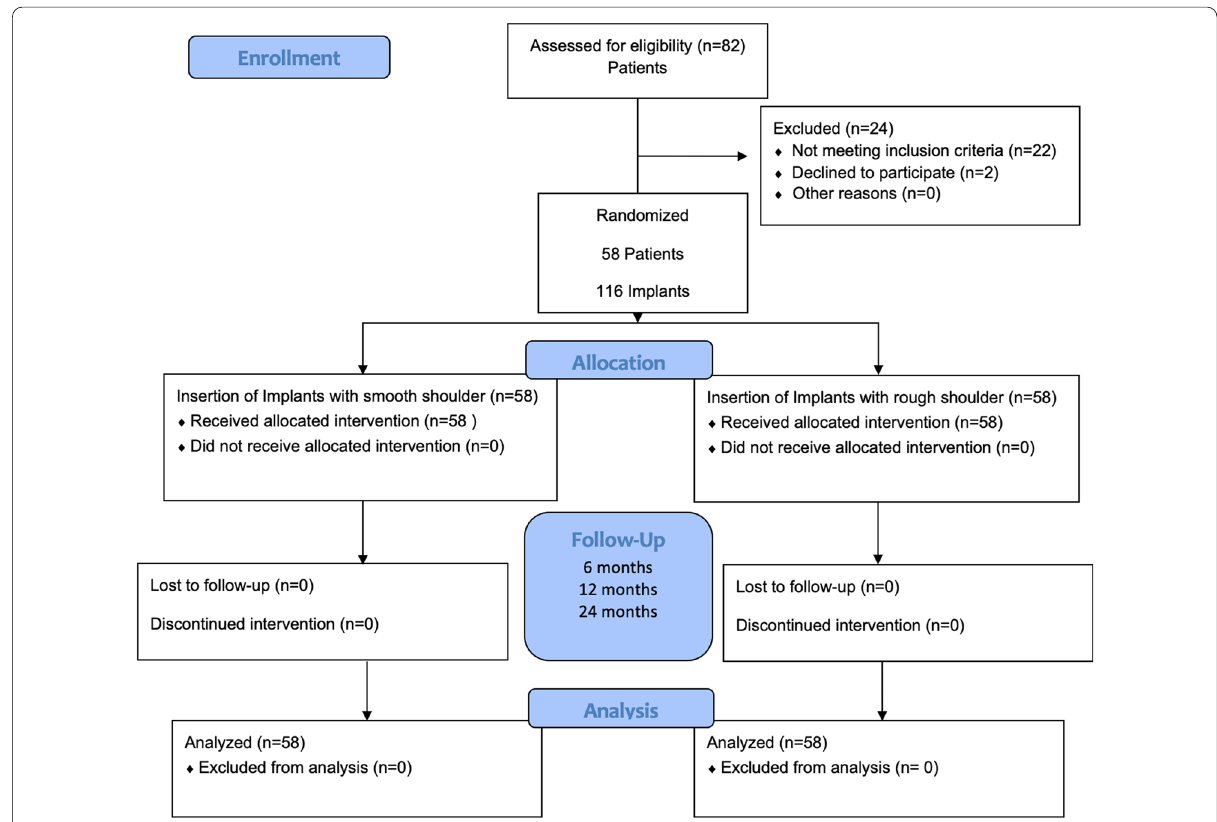
Fig. 1 Study design including evaluated patients and implants (modified CONSORT flow